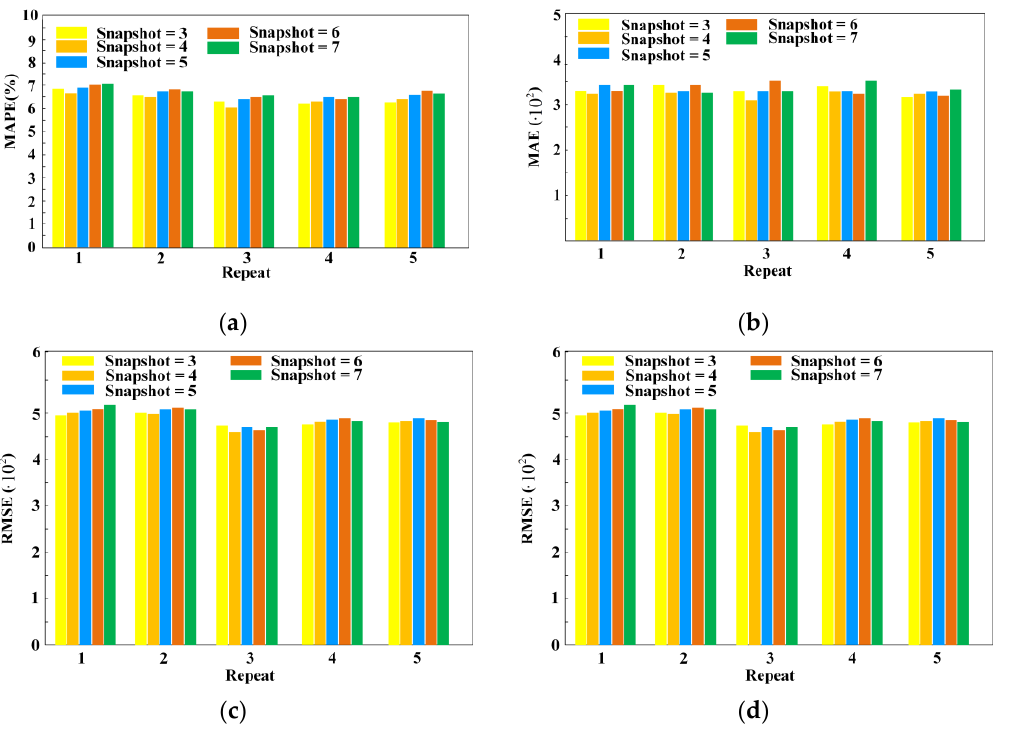
Figure 4. The performance comparison with different hyperparameters on the North American dataset: ( a ) mean absolute percentage error (MAPE); ( b ) mean absolute error (MAE); ( c ) root-mean- squared error (RMSE); ( d ) mean-squared error (MSE). Table 3. Performance comparison of MAPEs on the data of North American dataset during 1991 and 1992. Model Actual Temperature Noisy